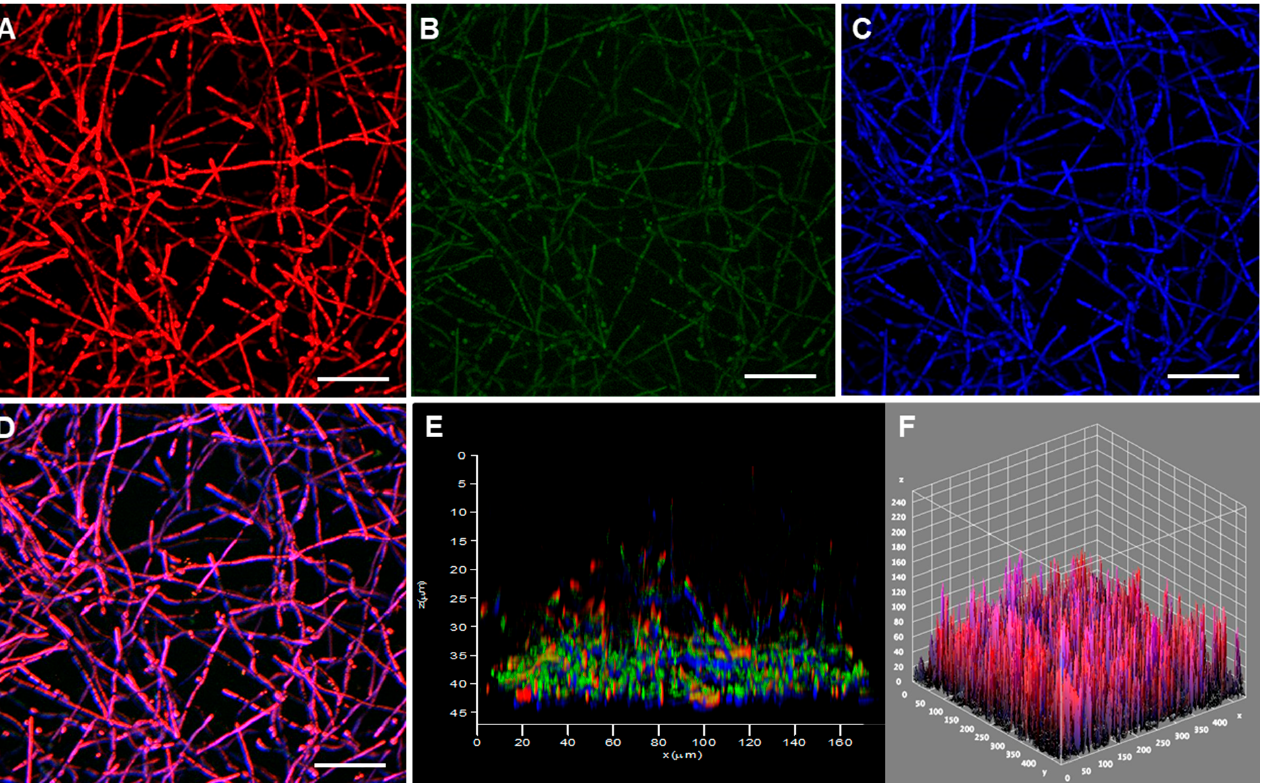
Figure 3. Confocal microscopy of the biofilm formed by F. pedrosoi cells on polystyrene. Conidia (1 × 10 6 ) were incubated at 37 °C in polystyrene confocal plates containing RPMI medium. After 48 h, the fungal cells were stained with ( A ) FilmTracer SYPRO ® , ( B ) TOTO TM , ( C ) calcofluor white M2R and ( D ) the staining combined. ( E , F ) 3-D reconstructions of the fungal biofilm. Bars, 20 µm.